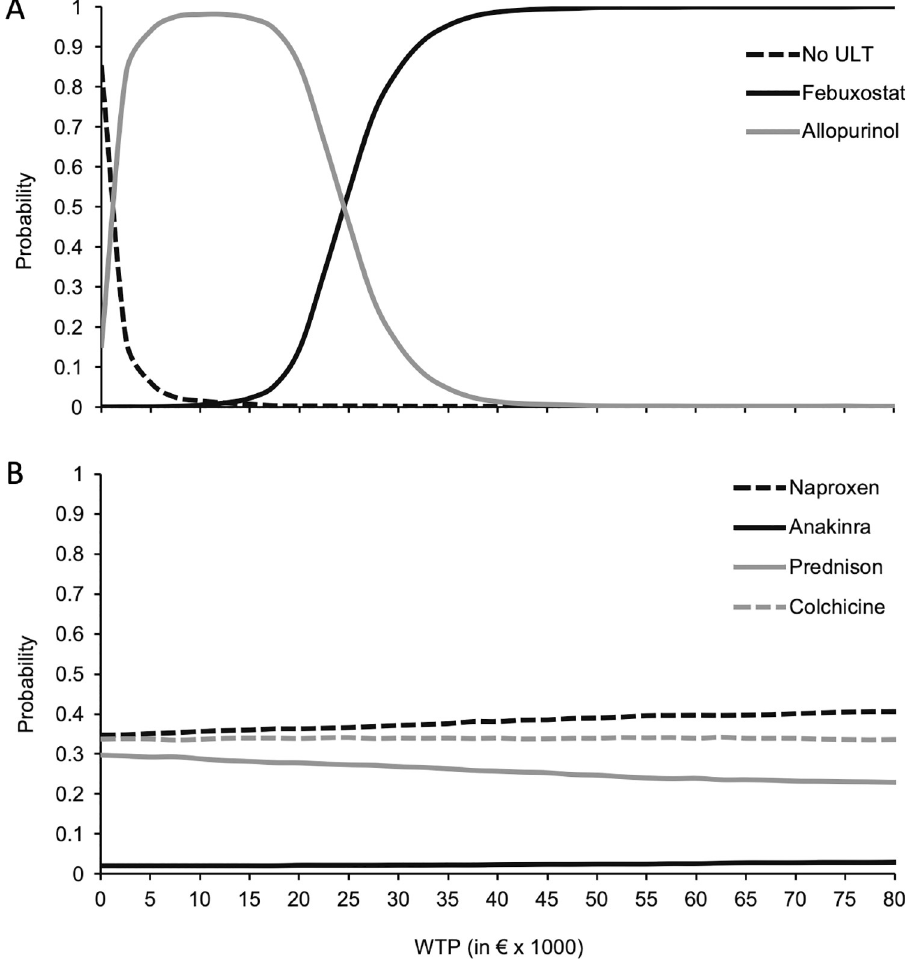
Fig 2. Cost-effectiveness acceptability curves (CEAC). ULT, urate lowering therapy; WTP, willingness-to-pay. Panel A displays the CEAC for different ULT combined with naproxen as the anti-inflammatory agent. Panel B displays the CEAC for different anti-inflammatory treatment options combined with febuxostat as the ULT.